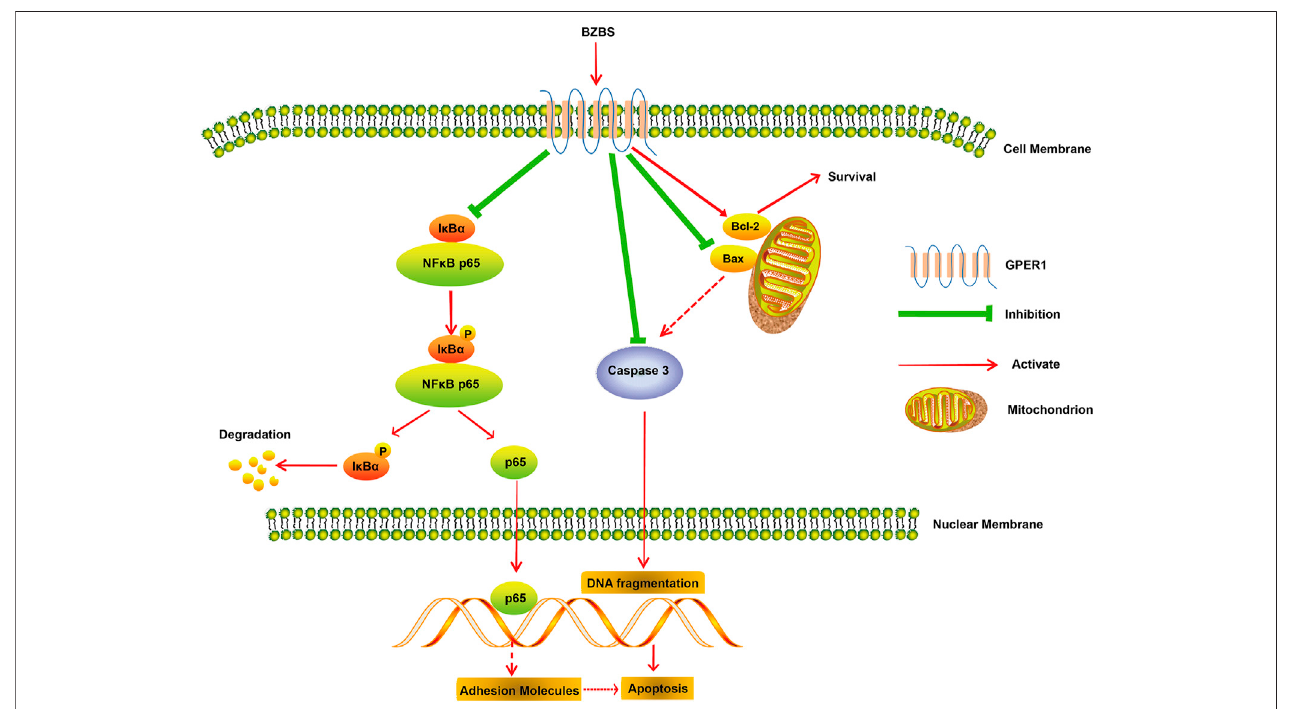
FIGURE 5 | Mechanism by which BZBS inhibits endothelial cell apoptosis through GPER1 mediated regulation.